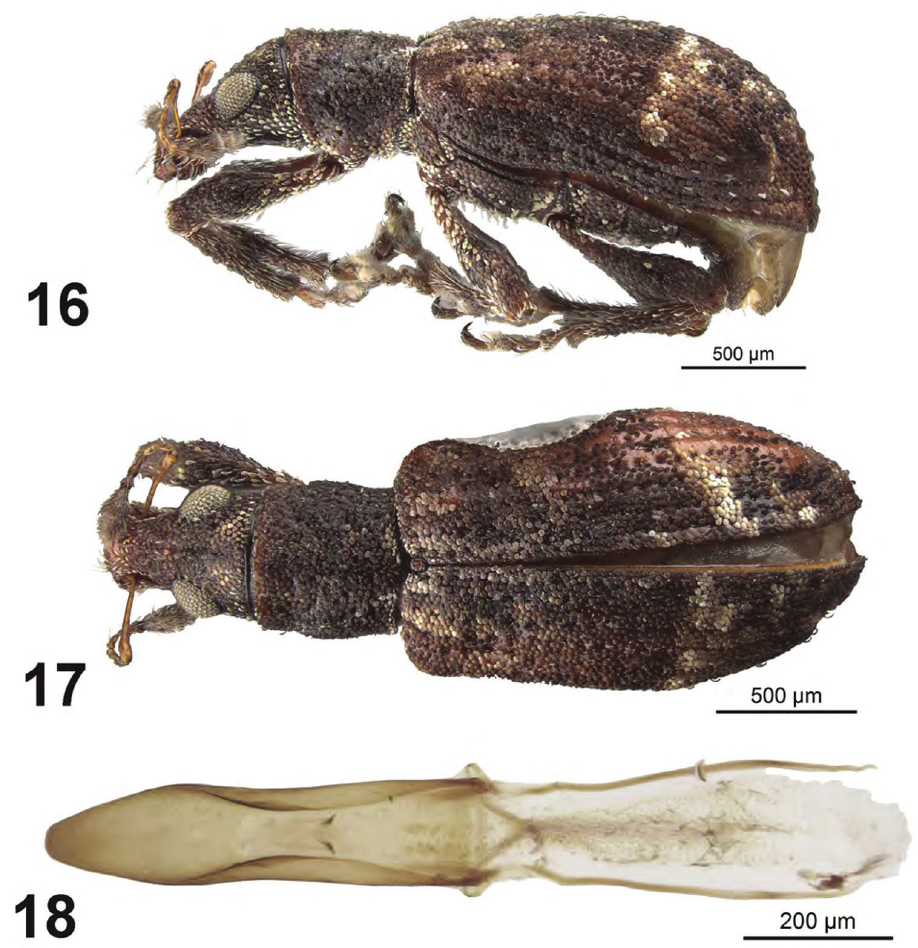
Figures 16–18. Apodrosus mensurensis. 16 Lateral habitus, male 17 Dorsal habitus, male 18 Male aedeagus,